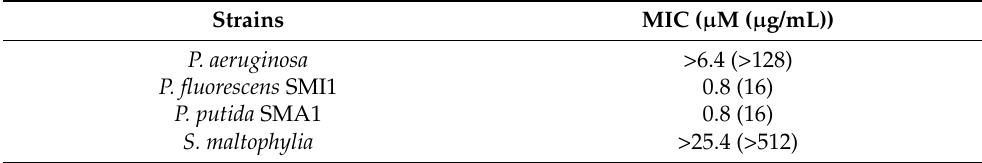
Table 3. MIC values of G5-PDK on Gram-negative bacteria of Pseudomonas and Stenotrophomonas genera obtained from experiments carried out in triplicate 1 , expressed as µ M and as µ